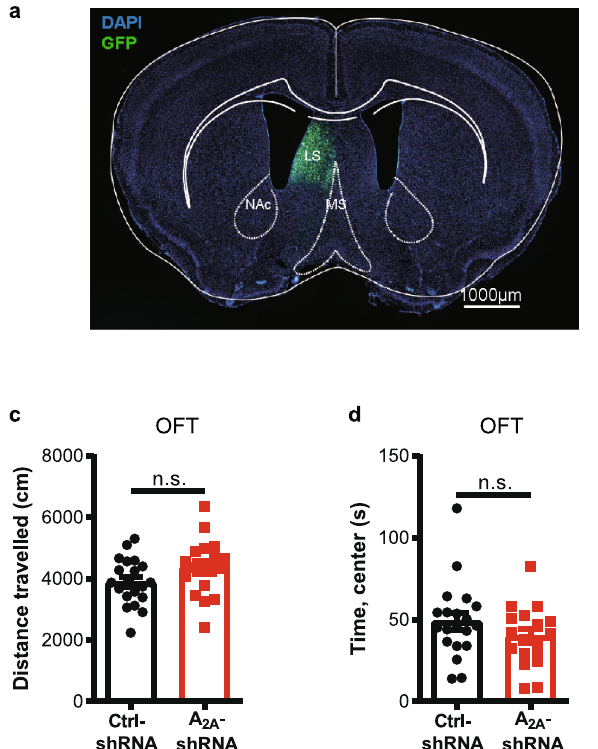
Fig. 8 | Focal genetic inactivation of A 2A R in the lateral septum (LS) affords an anti-depressant-like phenotype. a Left: A 2A R-speci fi c interference virus (AAV9- syn-A 2A RshRNA-GFP, A2AR-shRNA) and control virus (AAV9-syn-A 2A Rshcontrol- GFP, ctrl-shRNA) were unilaterally injected in the LS of C57BL/6J mice. Nuclei are stained with DAPI in blue. LS, lateral septum; MS, medial septum; NAc, Nucleus Accumbens core. Scale bar: 1000 μ m. Right: The downregulation of A 2A R in the LS was veri fi ed by qPCR ( n =3 and 4 mice per group for control and A 2A -shRNA, respectively.Unpairedttest, p =0.0383,t(5)=2.794). b ThedownregulationofA 2A R reduced immobility in the tail suspension test (TST) ( n =20 and 18 miceper group for control and A 2A -shRNA, respectively, Unpaired t test, p =0.0049, t(36)=2.995)